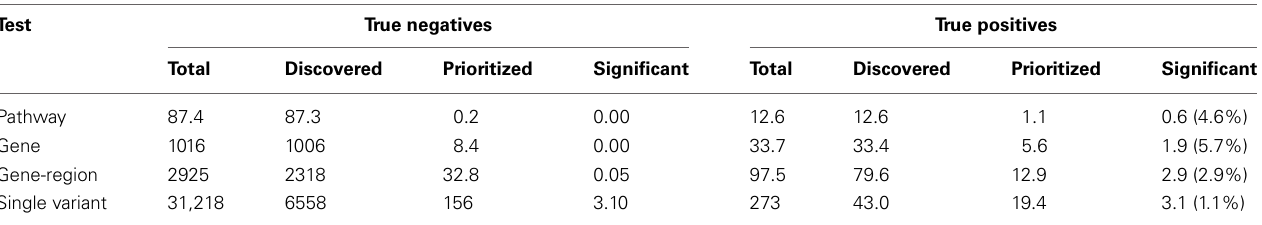
Table 3 | Simulated results of hypotheses tested in the main study for various levels of aggregation in the planned WECARE Study; means over 100 replicate